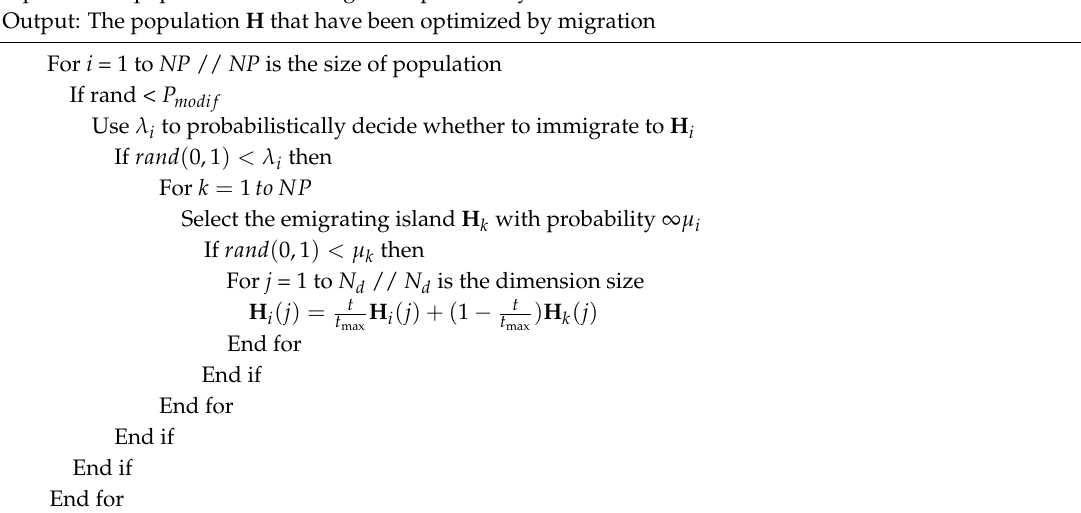
Algorithm 1: Migration for the MDP (MigrationDo( H , P modif